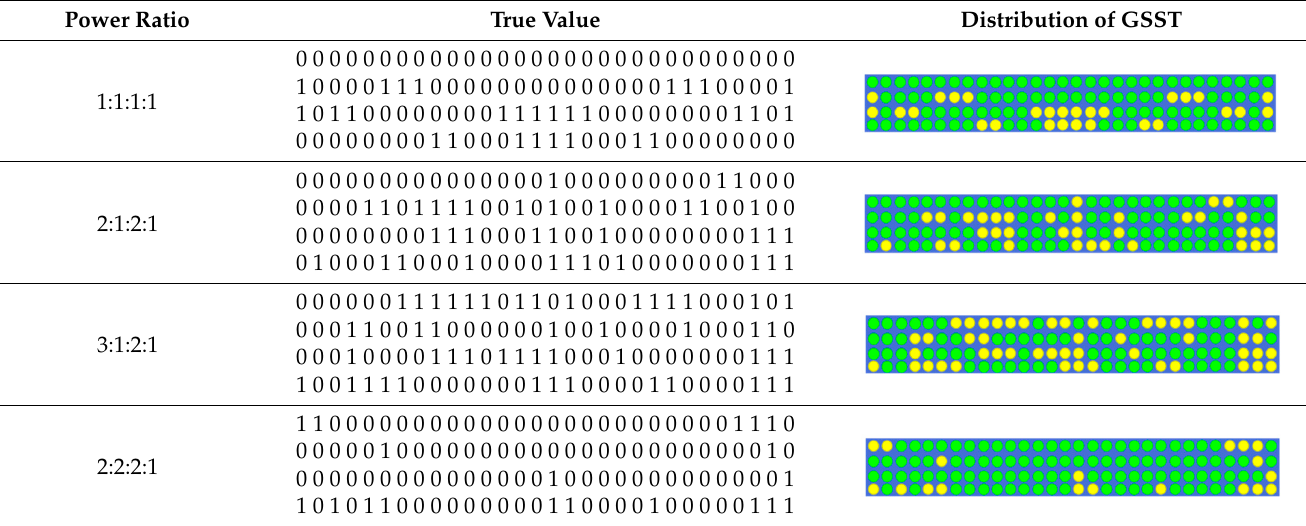
Table 3. Truth tables of 1 × 4 power splitter corresponding to different split ratios. There are four output channels and then a bigger GSST spot array (30*4) have to be used to control the split ratio. Power Ratio True Value Distribution of GSST Power Ratio True Value Distribution of GSST